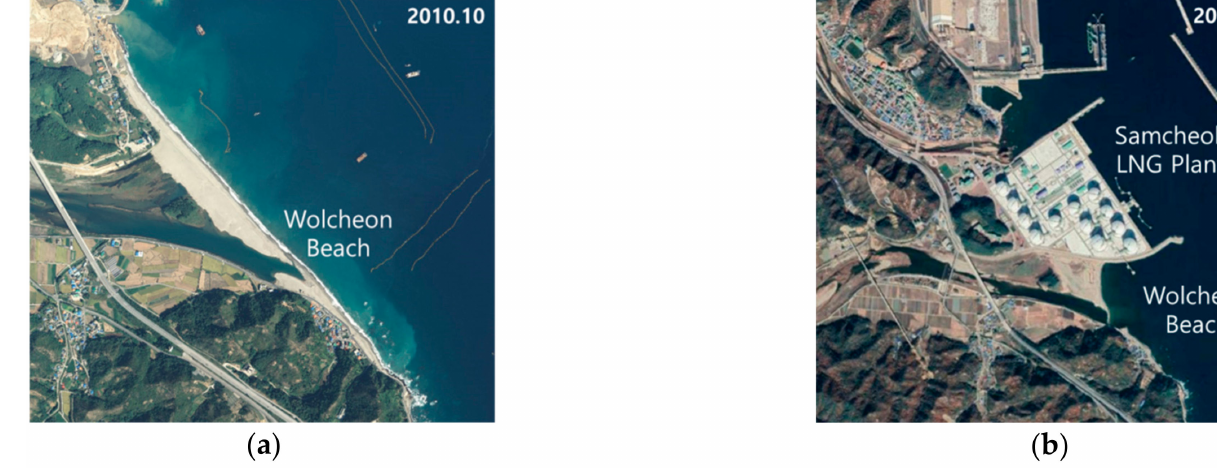
Figure 15. Wolcheon beach before and after construction of Samcheok LNG Plant: ( a ) October 2010 (image from NGII); ( b ) November 2019 (image from Google